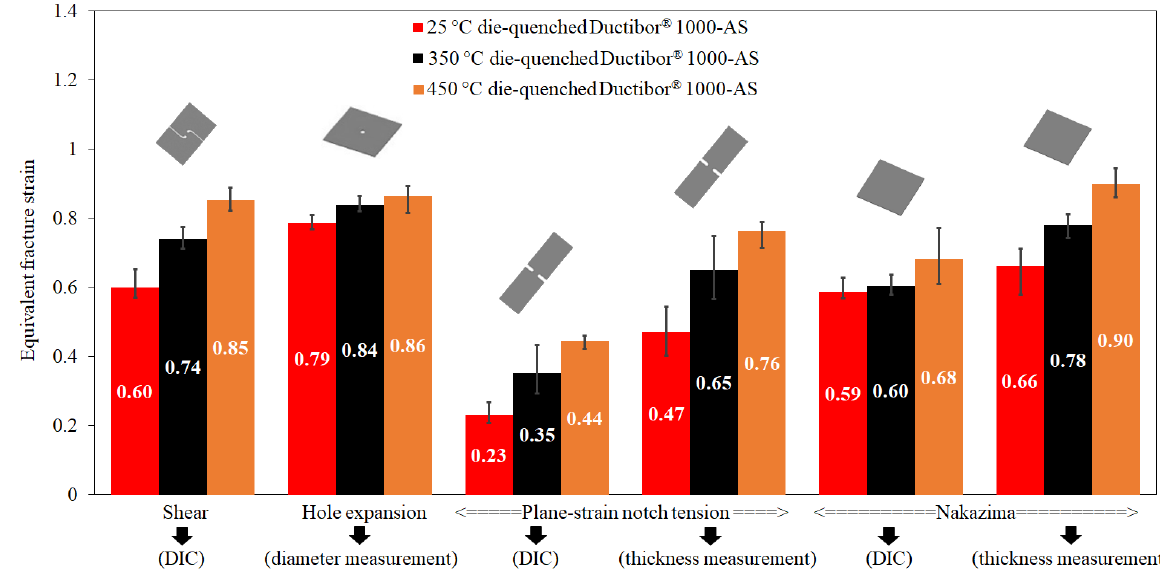
Figure 12. The equivalent fracture strains of various die-quenched conditions of Ductibor ® 1000-AS for each fracture test. The scatter of the measured data is denoted by the error bars.